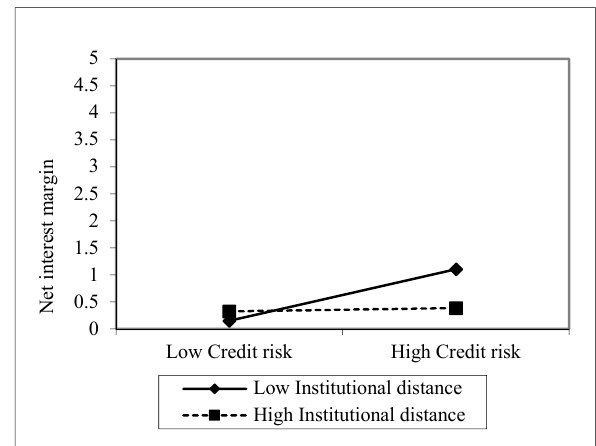
Figure 8. Bank Branch × Cultural Distance.